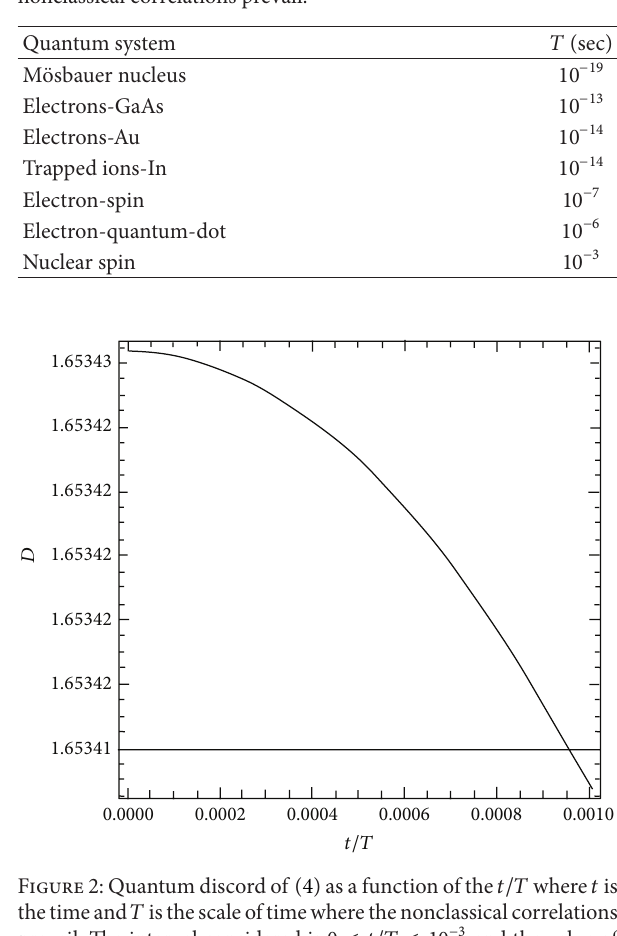
Table 1: Values of the minimum time required to execute one quantum gate for several different devices. The employed data is the same of [17]. The time 𝑇 is approximately the scale of time where the nonclassical correlations prevail.